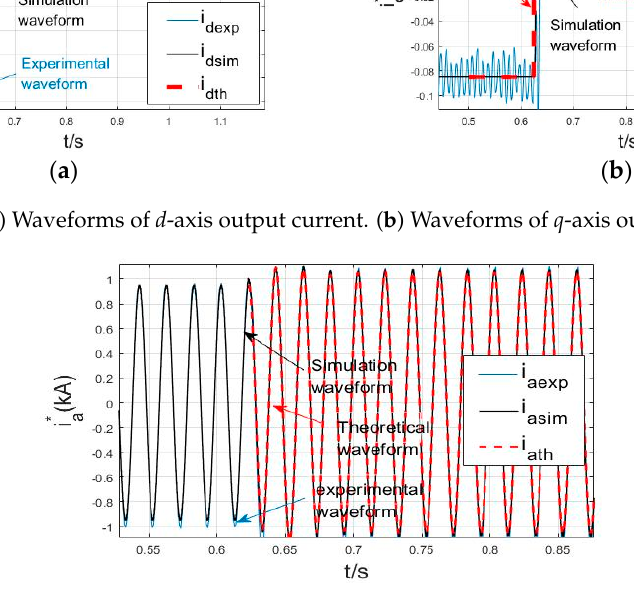
Figure 19. Waveforms of phase-A output current.